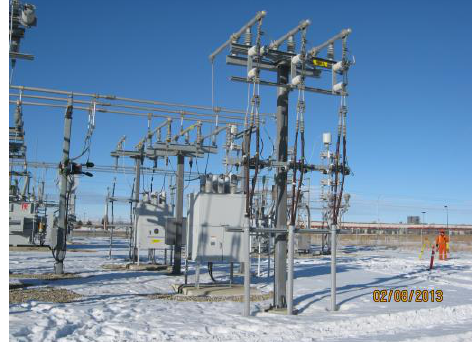
Figure 2. The scanned electrical substation